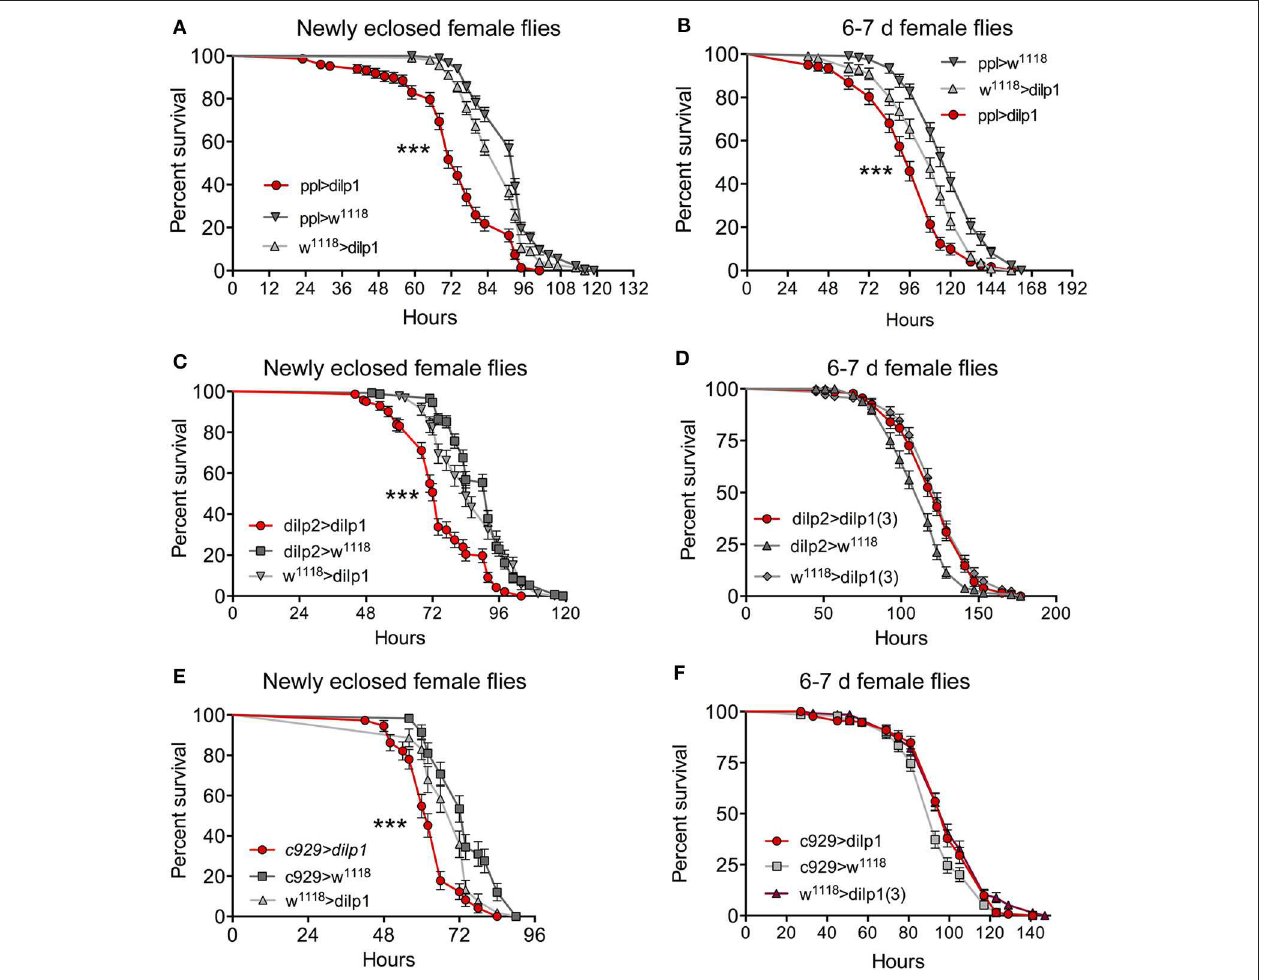
FIGURE 7 | Overexpression of dilp1 in the fat body affects starvation resistance in adult flies. (A , B) In recently eclosed (A) and 6- to 7-day-old (B) female flies, overexpression of dilp1 (with ppl-Gal4) leads to a decrease in survival during starvation n = 147–201 flies per genotype from three independent replicates [*** p < 0.001, as assessed by log-rank (Mantel–Cox) test]. (C,D) Expressing dilp1 in IPCs with a dilp2 -Gal4 driver also diminishes starvation survival in recently eclosed flies, n = 92–148 flies from three independent replicates [*** p < 0.001, as assessed by log-rank (Mantel–Cox) test], but not in 6- to 7-day flies ( n = 122–132 flies from three independent replicates). (E,F) Using c929 to drive dilp1 in recently eclosed and 6- to 7-day-old adult flies altered starvation resistance only in the recently eclosed ones [*** p < 0.001 as assessed by log-rank (Mantel–Cox) test, n = 132–135 flies per genotype from three independent